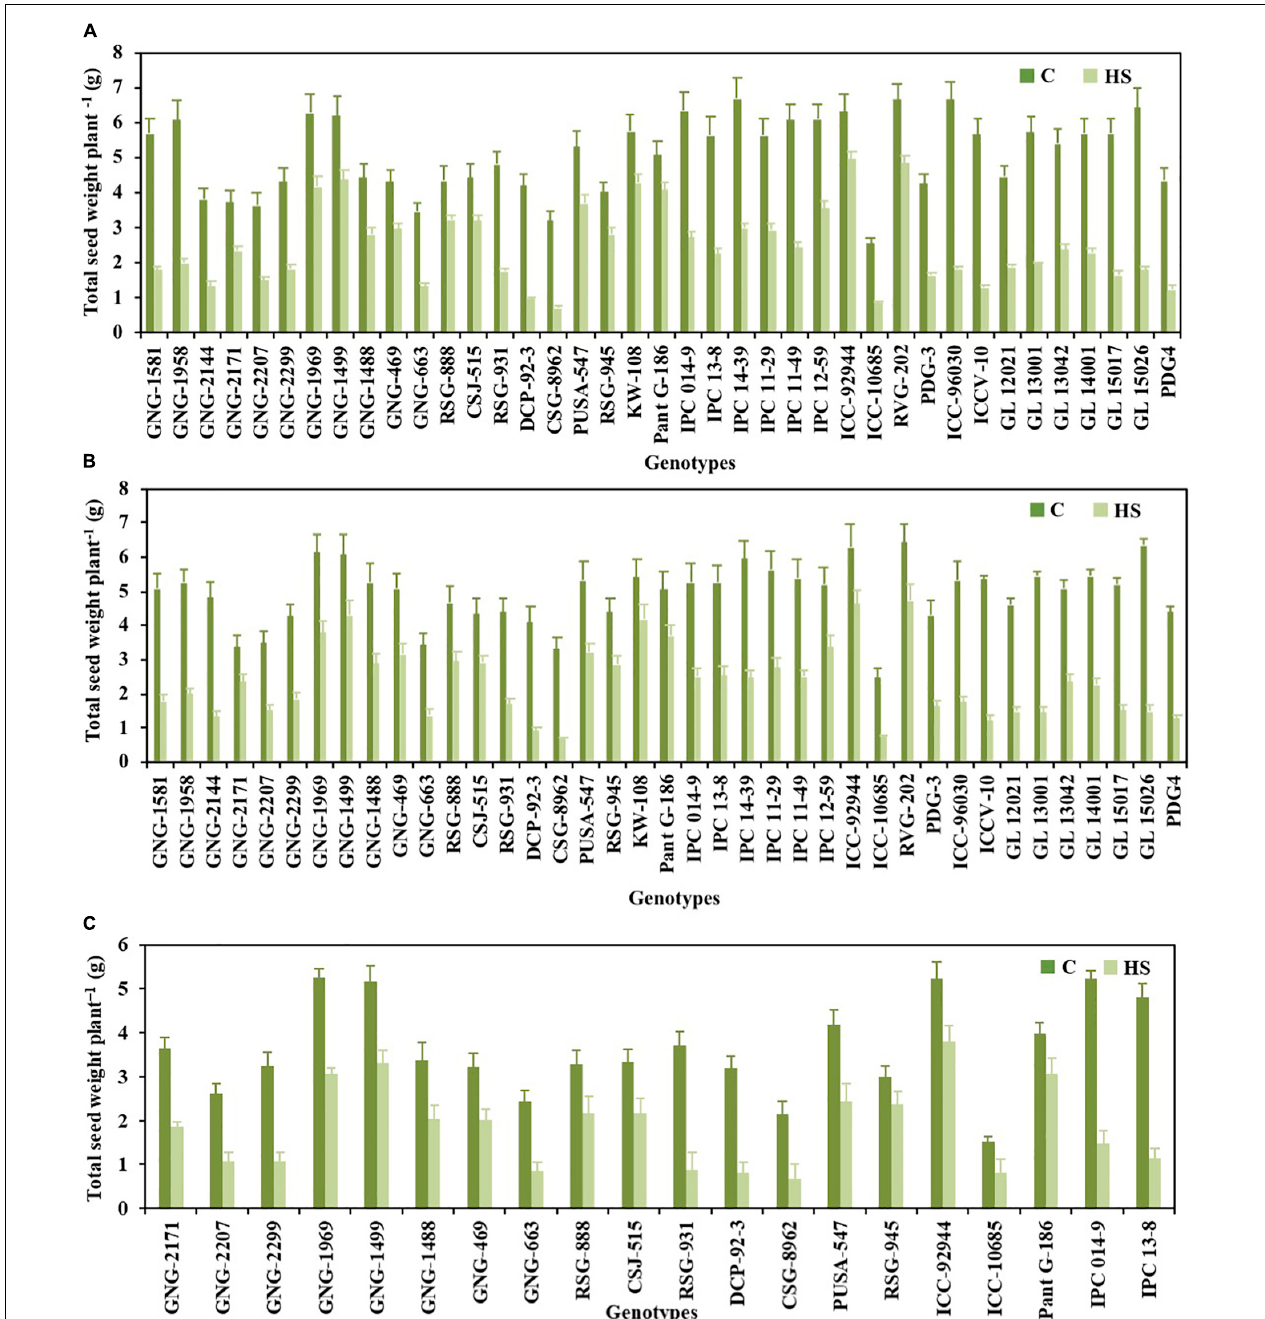
FIGURE 4 | Seed weight plant - 1 of chickpea genotypes under control (normal-sown; C) and heat stress (late-sown; HS) environment during 2017–2018 (A) , 2018–2019 (B) and in control environment of growth chamber (GC; C-control; HS-heat stress; C) . Values are means + SE. ( n =